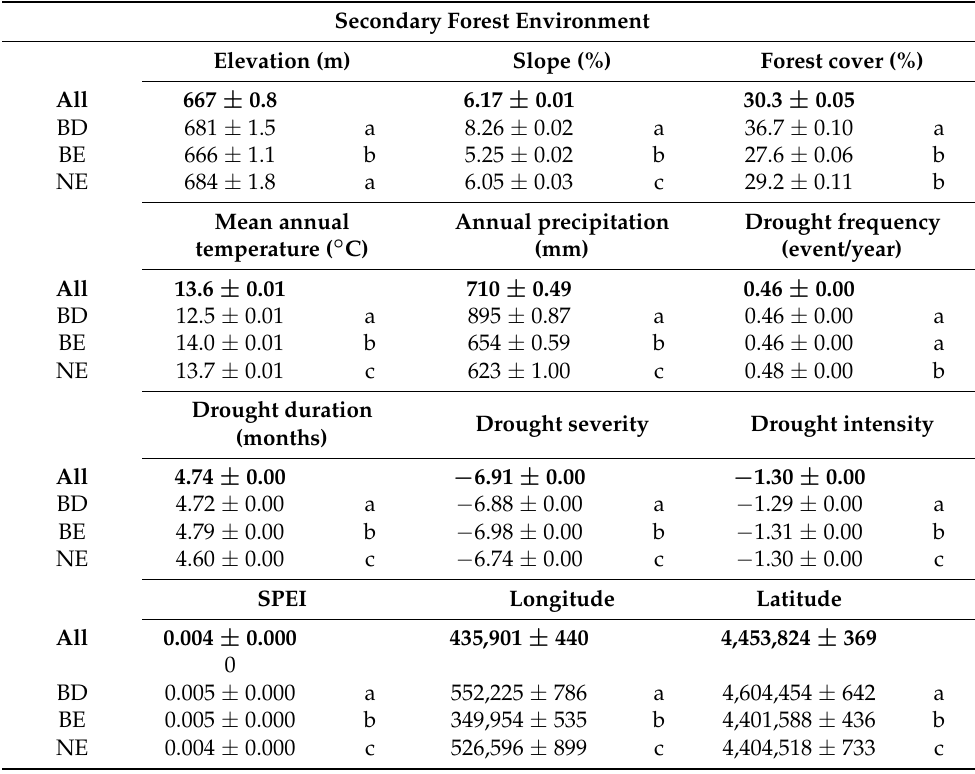
Table 1. Mean ( ± SE) values of environmental variables for sites with secondary forests and differ- ences between secondary forest leaf-habit: broadleaf deciduous (BD), broadleaf evergreen (BE) and needleleaf evergreen (NE). Letters show significantly different means at p <